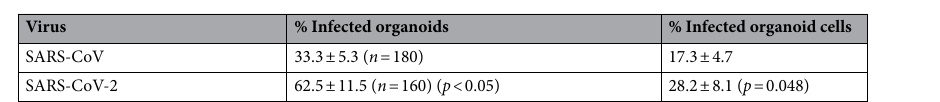
Figure 3. Human liver organoids are susceptible to infection by SARS-CoV-2 and other coronaviruses. ( A ) Immunofluorescence staining for SARS-CoV nucleocapsid protein (Sco-Np) of mock and SARS-CoV-2 infected organoids at 48 h and 72 h post-infection (4 organoids shown). ( B ) Immunofluorescence staining for SARS- CoV nucleocapsid protein (Sco-Np) of mock and SARS-CoV infected organoids at 72 h post-infection.